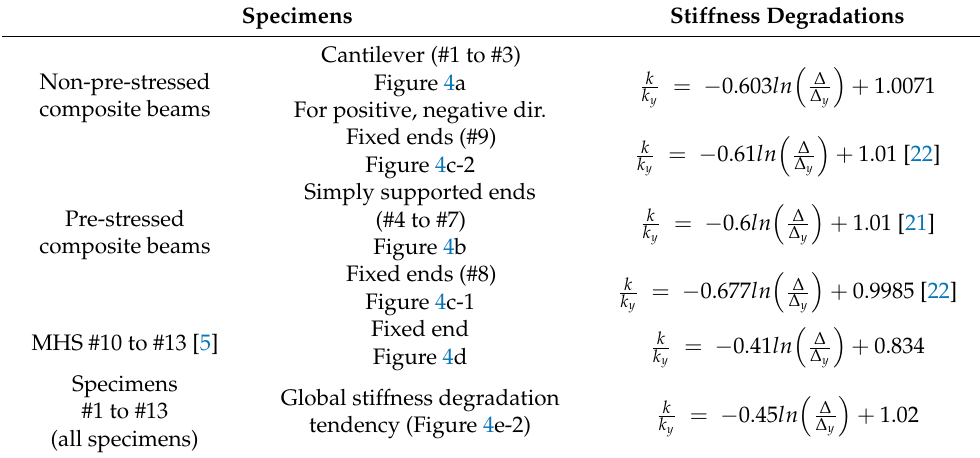
Table 3. Summary of stiffness degradation [7]